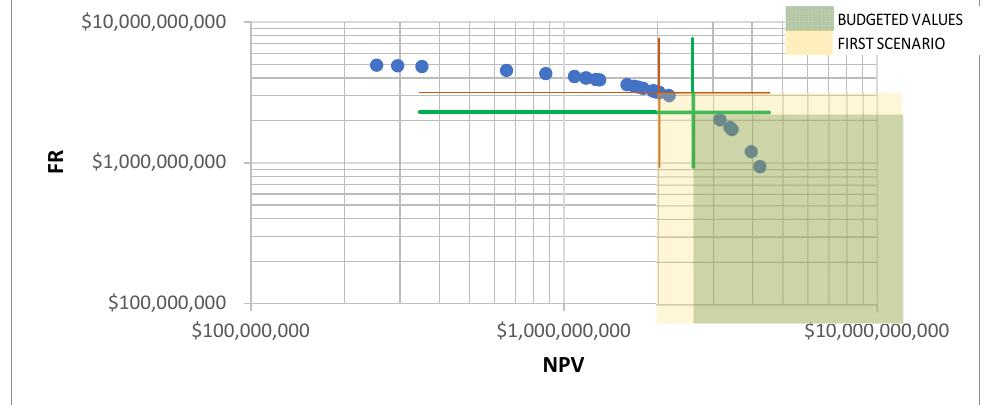
Fig. 6. Pareto solutions front without perturbations